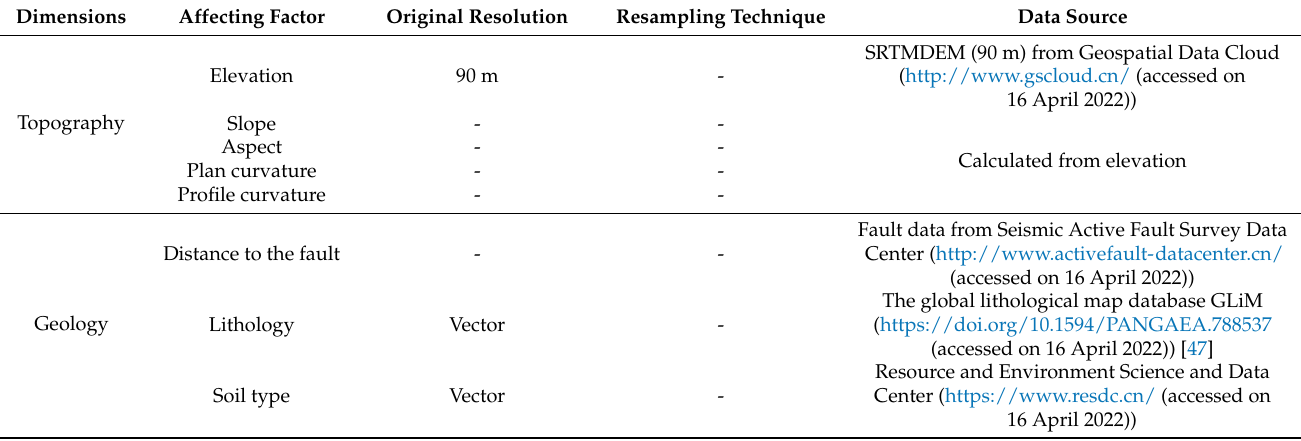
Table 1. Introduction of affecting factors